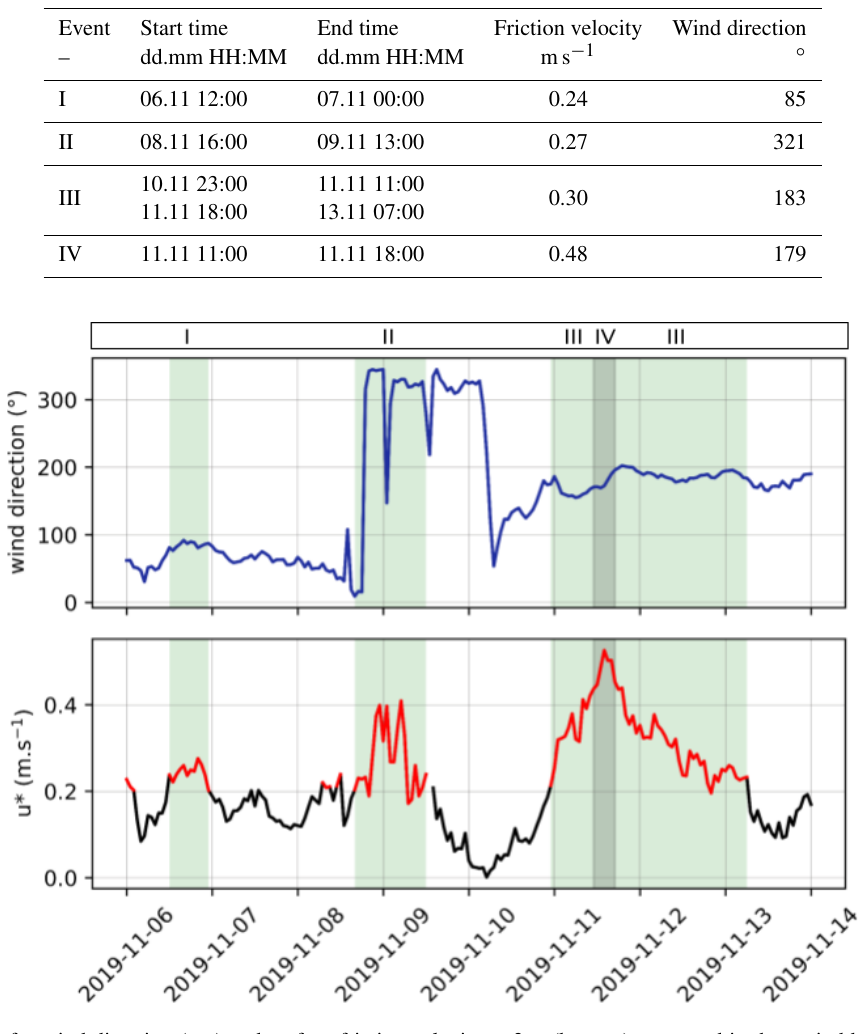
Figure 3. Time series for wind direction (top) and surface friction velocity at 2m (bottom) measured in the period between the successive TLS measurements. The values displayed are an average of measurements taken at 2, 6 and 10m height. The green-colored areas (I to III) correspond to the time periods for which snow movement was assumed to occur. The darker area (IV) shows the time span during which precipitation was measured by the radar. Source: Cox et al. (2021).